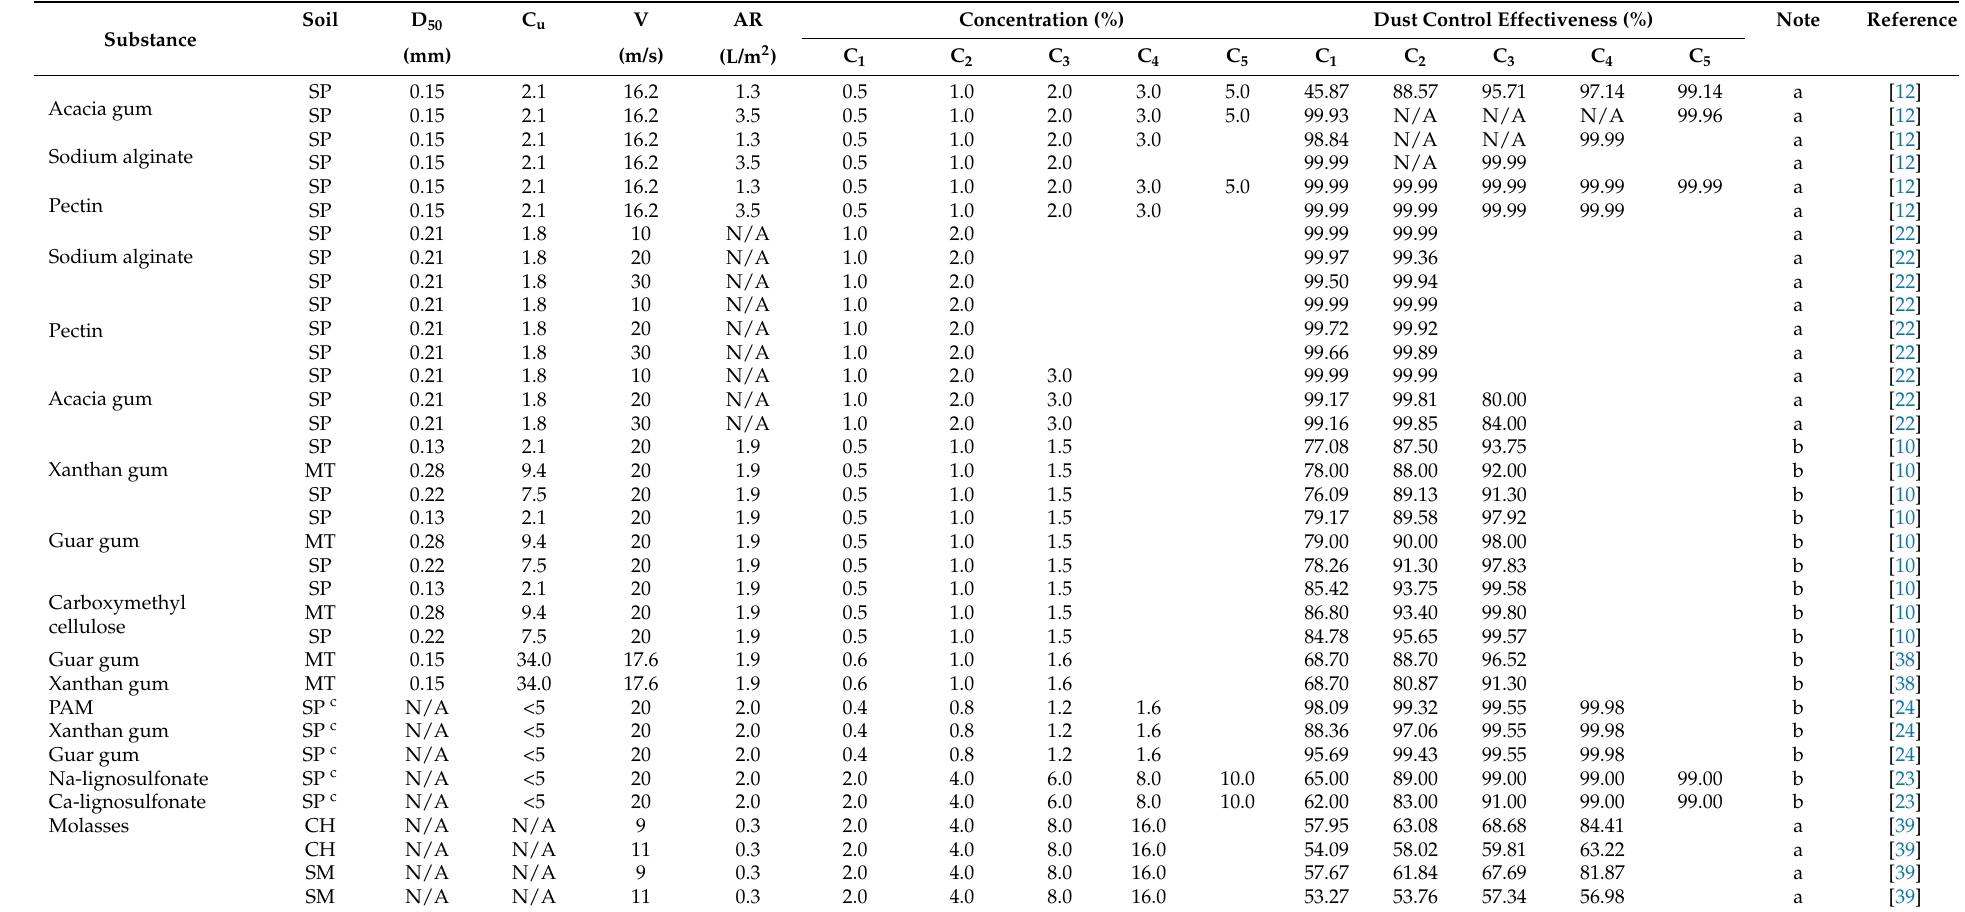
Table A6. Compilation of results from previous studies performing wind tunnel tests. The experimental methodologies and set-ups applied in the studies below (e.g., wind tunnel type, velocity, exposure time, or sample angle) partially differ. For studies that did not directly report dust control effectiveness, the effectiveness was calculated based on data from the original sources according to Equation (1) (cf. Section